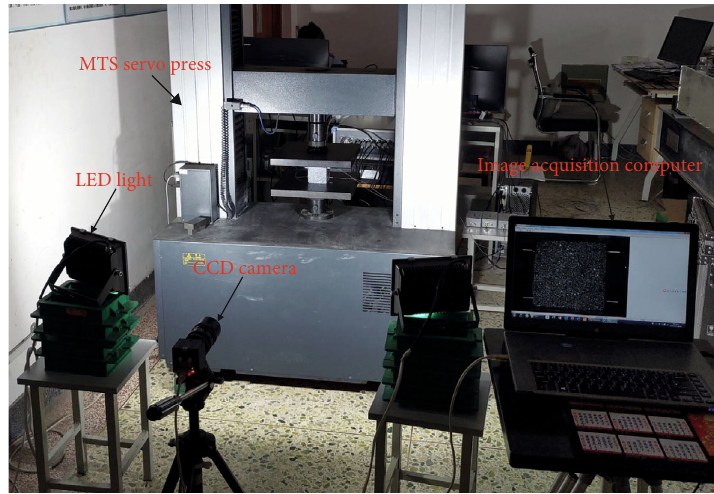
Figure 1: Actual picture of testing system.